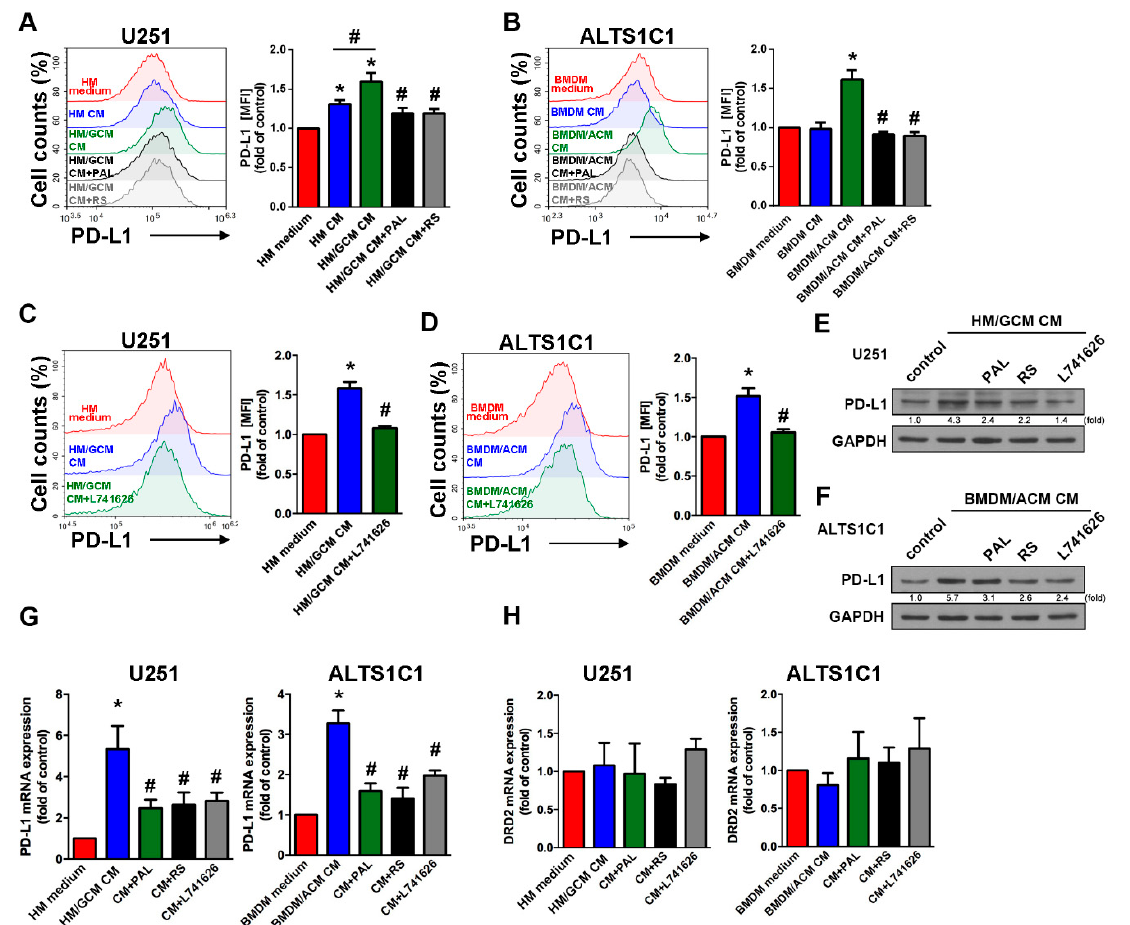
Figure 5. DRD2 is involved in the interaction of GBM-macrophage-induced PD-L1 expression in GBM. ( A , C , E ) Human U251 GBMs were incubated with human macrophage (HM) cultured medium, HM CM or HM/GCM CM, and then treated with paliperidone (20 μ M, PAL), risperidone (20 μ M, RS), or L741626 (1 μ M) for 48 h. ( B , D , F ) Mouse ALTS1C1 GBMs were incubated with BMDMs cultured medium, BMDMs CM or BMDM/ACM CM, and then treated with or without PAL (20 μ M), risperidone (20 μ M, RS), or L741626 (1 μ M) for 48 h. PD-L1 expression on the cell surface was determined by flow cytometry analysis ( A – D ) and Western blot ( E , F ). * p < 0.05 compared with HM medium group. # p < 0.05 compared with HM/GCM CM group. ( n = 3–4) ( G , H ) mRNA levels of PD-L1 and DRD2 were determined by real-time PCR. * p < 0.05 compared with HM medium or BMDMs medium groups. # p < 0.05 compared with HM/GCM CM or BMDM/ACM CM groups ( n = 3).